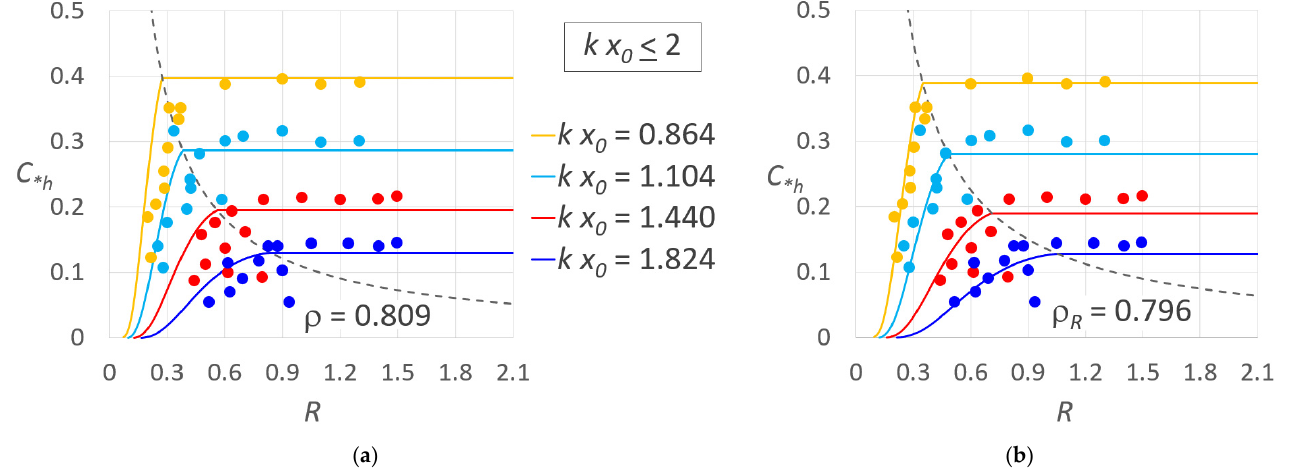
Figure 11. Relationship between the normalized hydraulic loading rate, C *h (Equation (36)), versus R ( a ) for ρ = 0.809 and ( b ) for ρ = 1 and ρ R = 0.796 for the k x 0 values ( k x 0 ≤ 2), corresponding to the experimental measurements carried out by d’Antonio and Carbone [34]. The corresponding values derived by d’Antonio and Carbone [34] are also plotted.